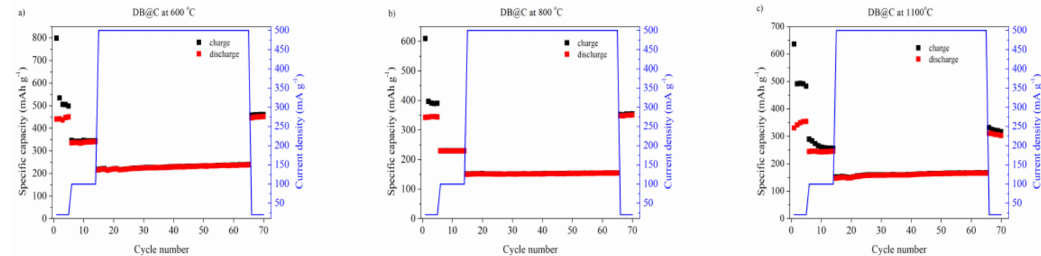
Figure 8. The capacity vs. cycle number of diatom biosilica electrodes at di ff erent current densities for ( a ) DB@C at 600 ◦ C, ( b ) DB@C at 800 ◦ C and ( c ) DB@C at 1100 ◦